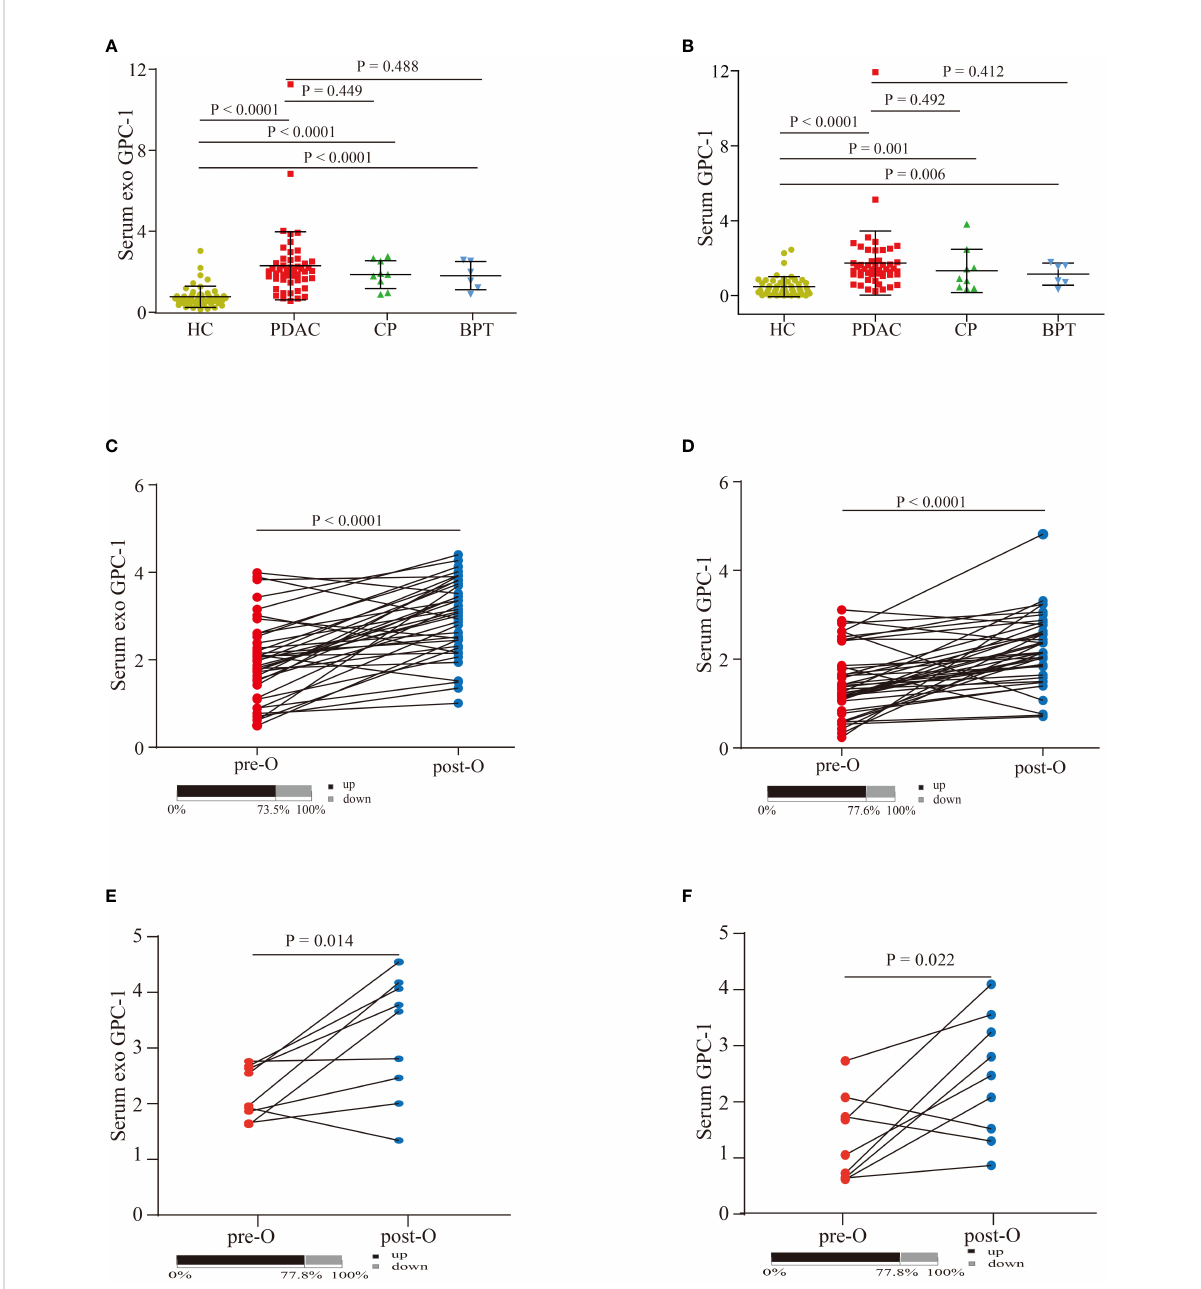
FIGURE 2 Serum exosomal and serum GPC-1 expression levels in patients with pancreatic diseases and HCs. (A) Serum exosomal GPC-1 levels in HCs and PDAC, CP, and BPT patients. (B) Serum GPC-1 expression levels in HC and PDAC, CP, and BPT patients. Preoperative and postoperative serum exosomal GPC-1 expression levels (C) and serum GPC-1 expression levels (D) in patients with PDAC. Preoperative and postoperative serum exosomal GPC-1 expression levels (E) and serum GPC-1 expression levels (F) in patients with CP and BPT. PDAC, pancreatic ductal carcinoma; HCs, healthy controls; CP, chronic pancreatitis; BPT, benign pancreatic